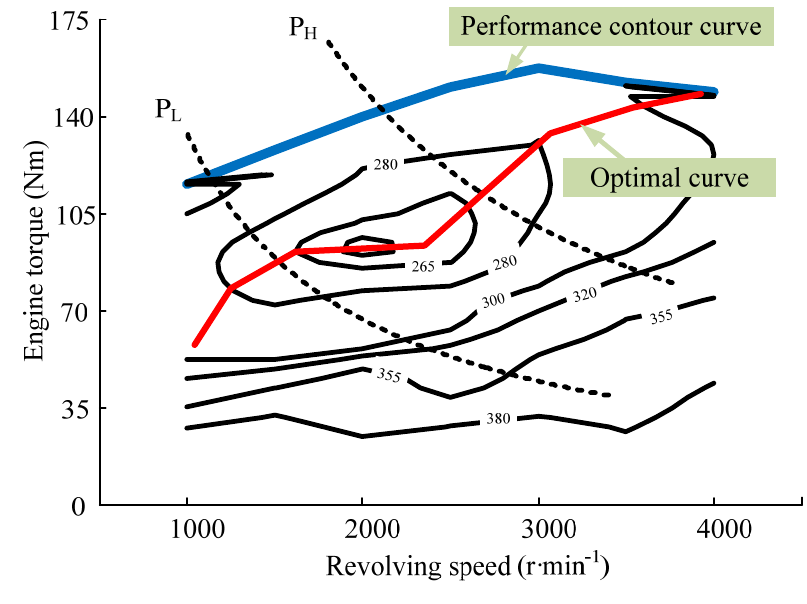
Figure 2. Efficiency map of the engine